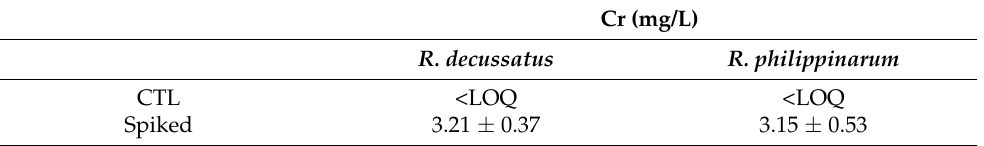
Table 2. Chromium (Cr) concentrations (mg/L) in water collected every week after spiking for each species in control (CTL) and spiked conditions. LOQ is the limit of quantification.